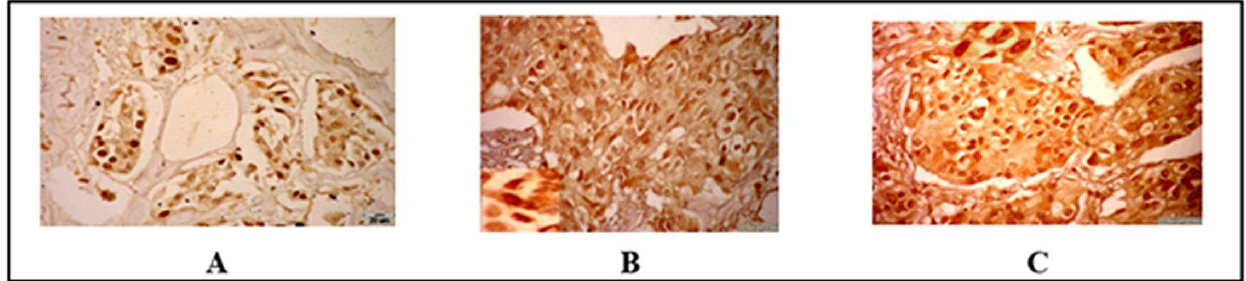
Figure 2: Immunohistochemical results of tested samples (ABC and DAB, BAR=20 µm). A: Benign Fibroadenoma case show a dark positive nuclei of Ki67 expression >20%. B: Malignant IDC grade II case show dark brown granules spread in nuclei ki-67 expression. C: Increased dark brown granules showed spread in nuclei of ki-67 expression. ABC: Avidin biotin